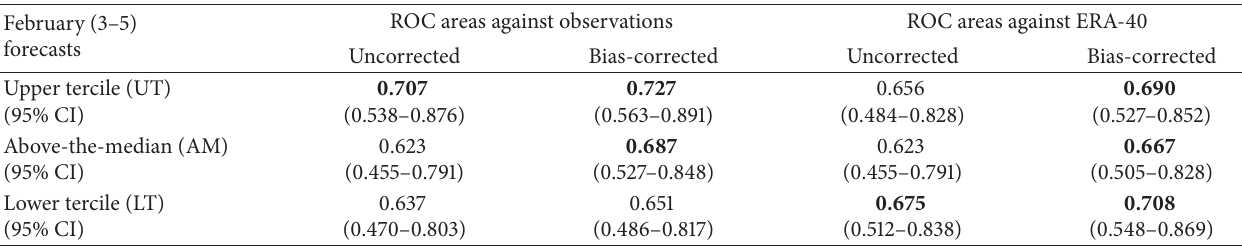
Table 1: ROC areas for February (3–5) forecasts by DEMETER-3 validated against observations and ERA-40 data over northern Pakistan. The range of values in brackets represents 95% CI calculated with 1000 bootstrap samples. ROC areas > 0.5 are skillful and < 0.5 are unskillful. Skillful forecasts are highlighted in bold values.